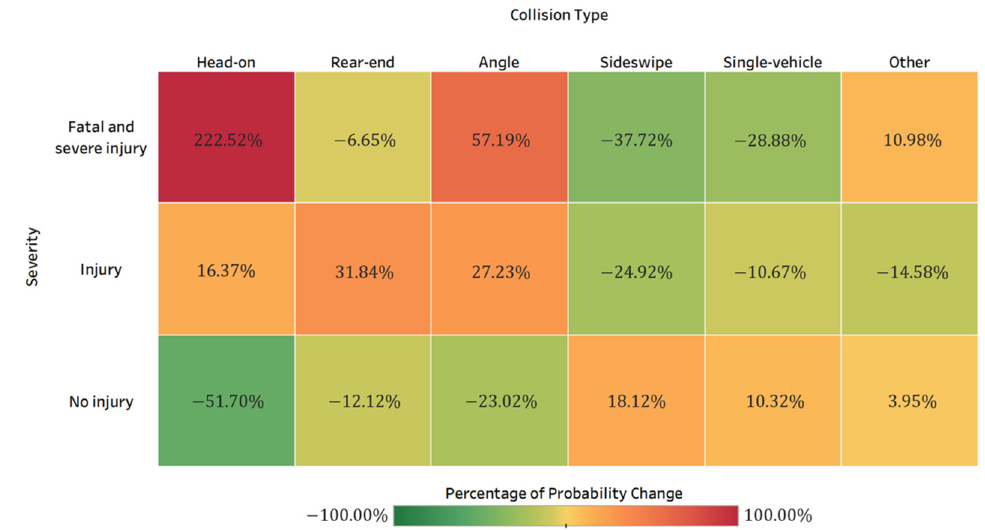
Figure 6. HAZMAT road transportation collision type proportions by crash severity.